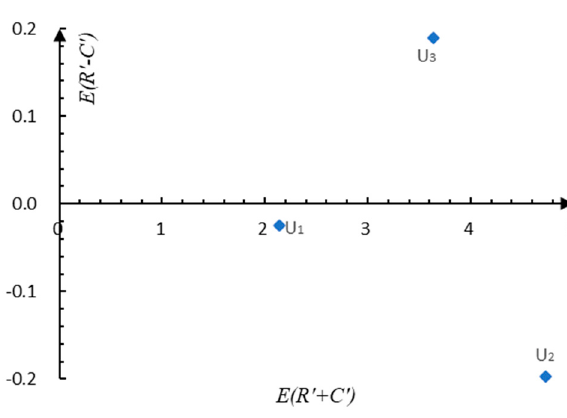
Figure 3. The casual diagram of the main criteria.